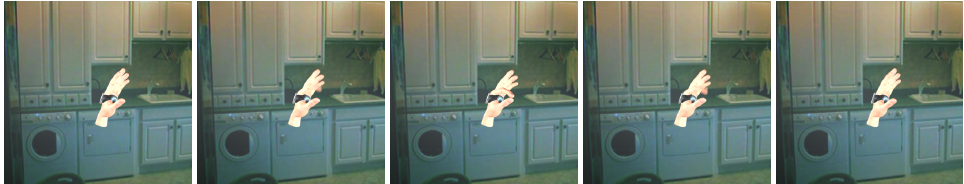
Figure 4. Examples of finger-tapping animation frames with motion blur.